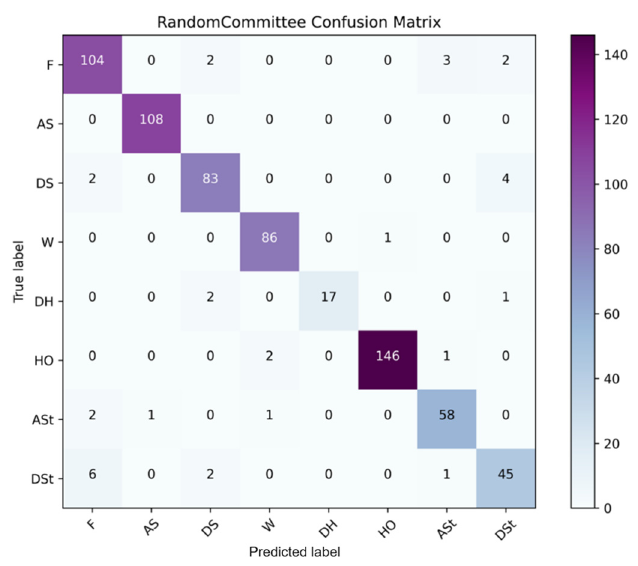
Figure 20. Random Committee Confusion Matrix Using DS2.